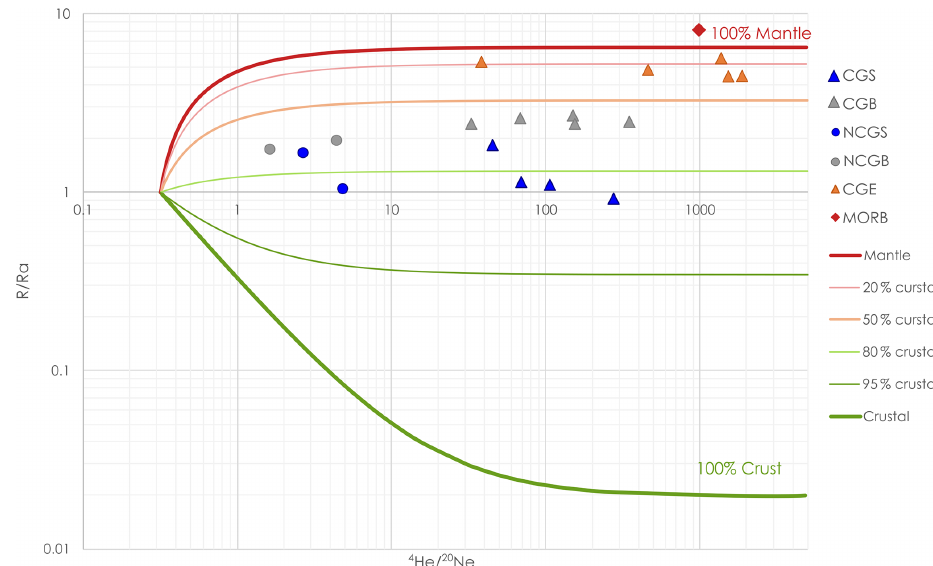
Figure 6. Proportion of crustal and mantle He in the samples, based on R / Ra and 4 He / 20 Ne values. CGB = carbogaseous water from the Bru area, CGS = carbogaseous water from the Spa area, CGE = carbogaseous water from the Eifel area, NCGB = non-carbogaseous water from the Bru area, and NCGS = non-carbogaseous water from the Spa area. Mixing lines are computed from Eqs. (3) and (2). Values from Eifel and MORB are depicted from Marty et al. (2020). He atmospheric contribution is negligible. He crustal contribution appears to be more important for CG samples from the Spa area, as the local lithology is richer in uranium